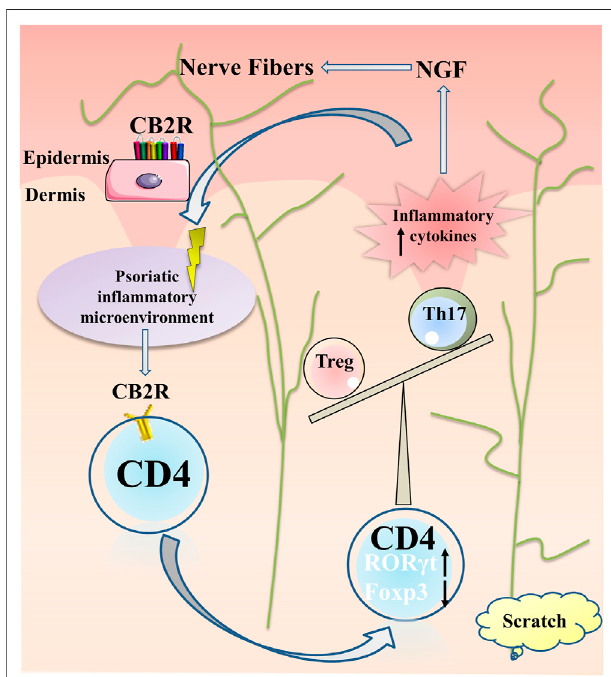
FIGURE 7 | Summary of CB2R actions in psoriatic in fl ammation and itch. Under the psoriatic in fl ammatory microenvironment, CB2R regulated proliferation and differentiation of CD4 + T cell, increased ROR- γ t expression and decreased Foxp3 expression, resulting in imbalance of Th17 and Treg cells, further aggravating the in fl ammatory microenvironment of psoriasis. The local high expression of a variety of in fl ammatory factors stimulated the keratinocytes secreting NGF for nerve fi ber hyperplasia, resulting in pruritus paresthesia.